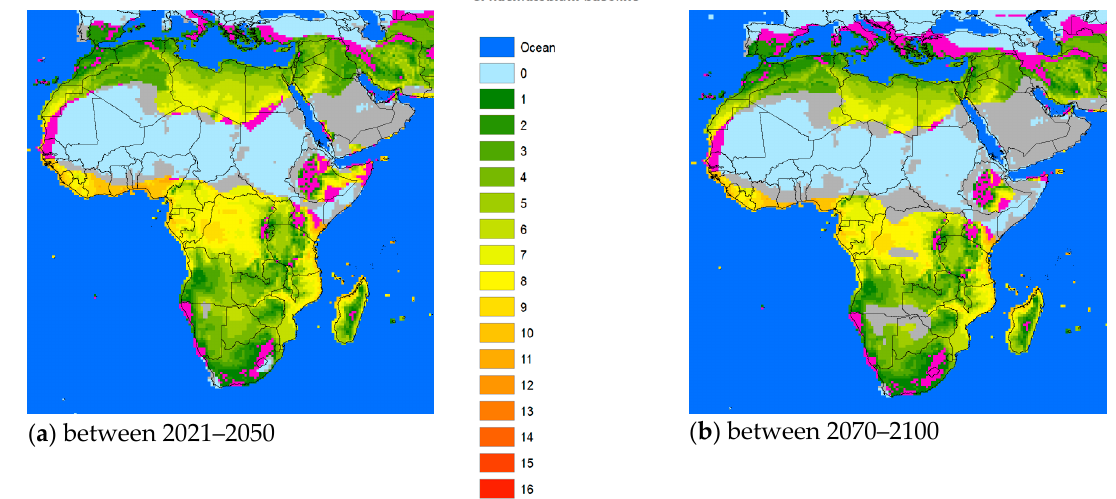
Figure 4. Change of risk area for S. haematobium vs. the baseline. ( a ) 2021–2050 vs. the baseline, ( b ) 2071–2050 vs. the baseline.